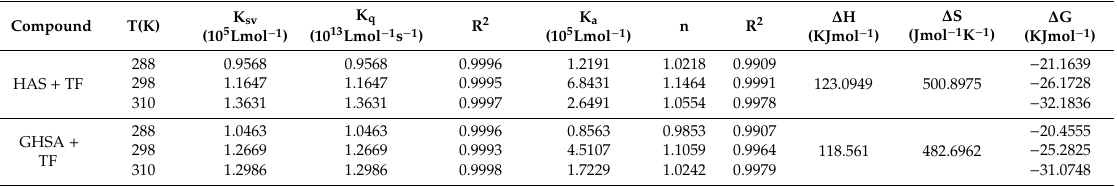
Table 1. Quenching constants, binding constants and thermodynamic parameters of the interaction between TF and HSA / GHSA at di ff erent